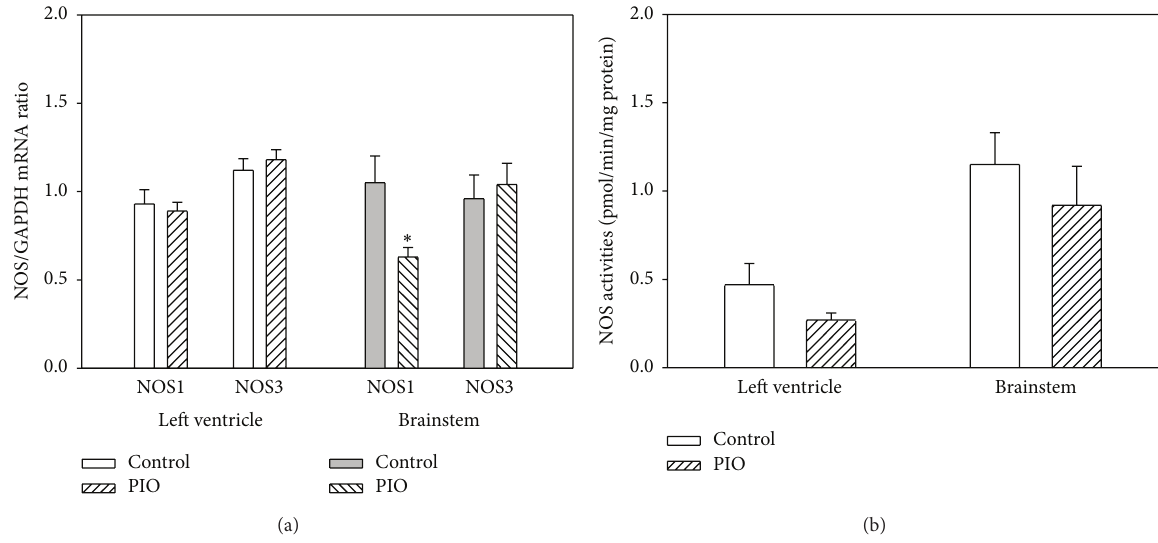
Figure 6: Effect of pioglitazone administration on nitric oxide synthase (NOS) expression and activities in the left ventricle and brainstem of young SHRs. (a) Expression of NOS1 and NOS3 isoforms was normalized to the expression of GAPDH. Data are shown for the left ventricle and brainstem. Bars represent mean ± SEM, 𝑛 = 7 . ∗ 𝑃 < 0.05 , PIO versus control. (b) The NOS activities were determined using conversion of radioactive 3 H-Arginine to 3 H-Citrulline. The specific activities are expressed in pmols of citrulline produced in one min and related to 1mg of proteins. Data are presented as mean ± SEM, 𝑛 = 7